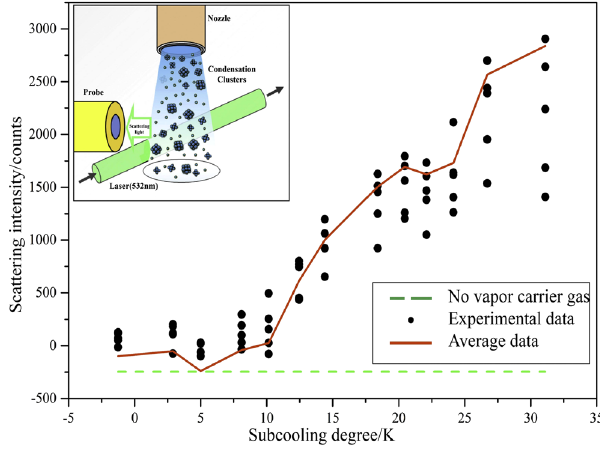
Figure 3. Clusters jet scattering intensity affected by subcooling degree.